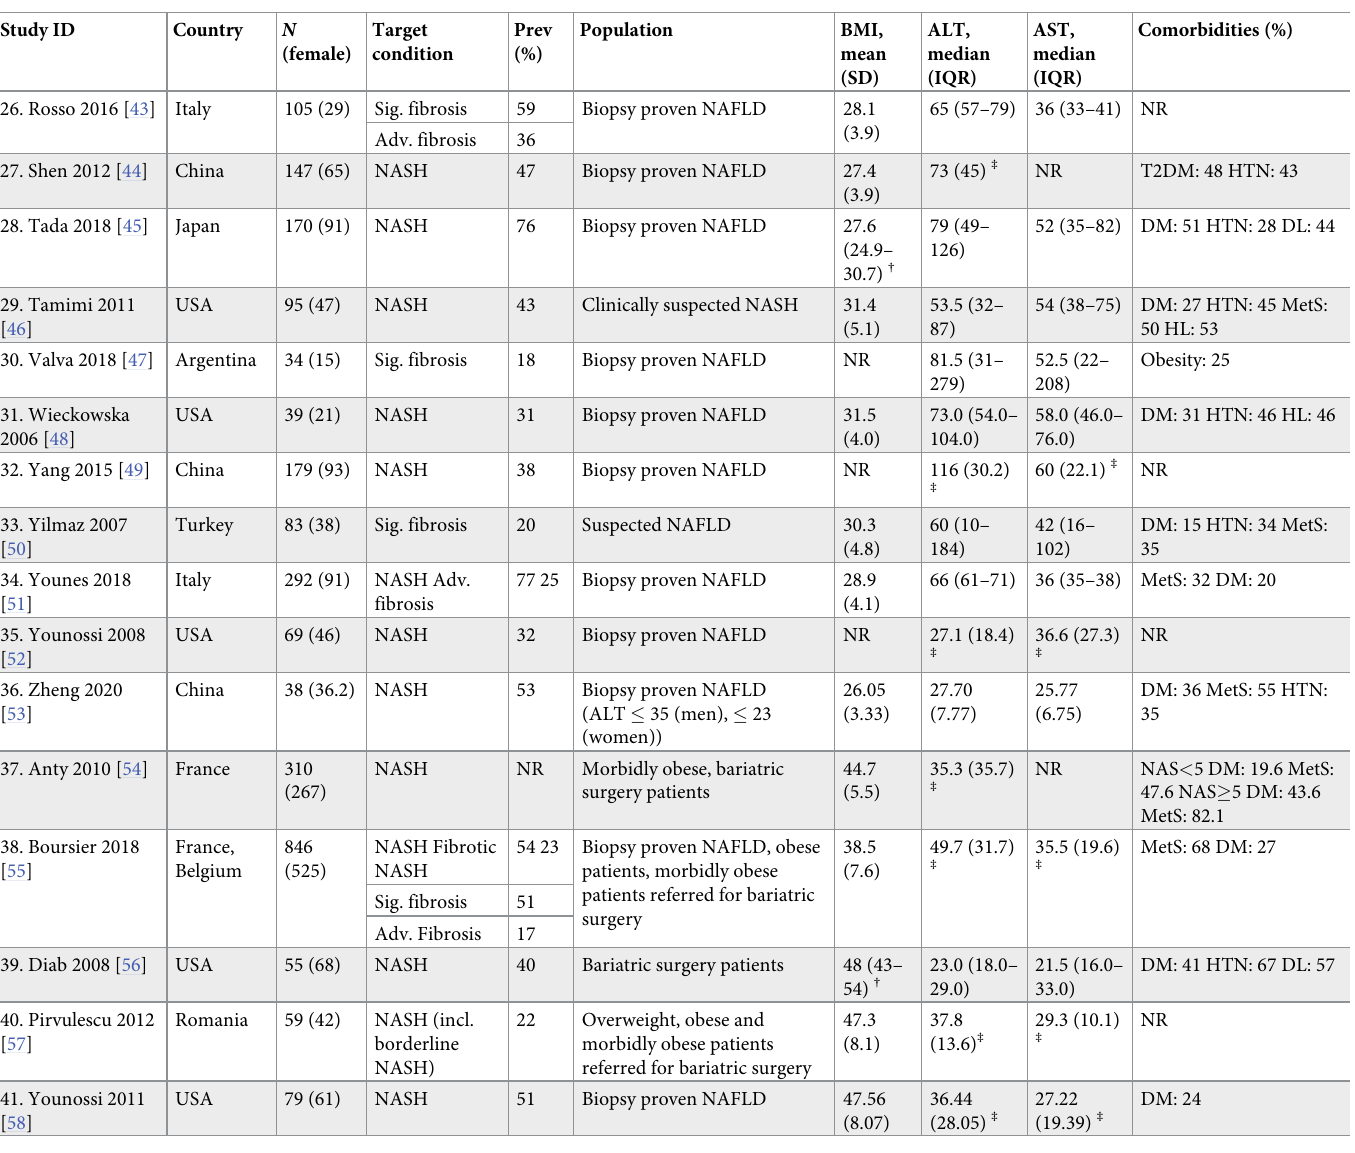
operating characteristic curve (AUC) of 0.75 (95% CI: 0.69–0.82) with a mean sensitivity of 0.61 (95% CI: 0.51–0.71) and mean specificity of 0.81 (95% CI: 0.71–0.88). The Youden-thresh- old value was 304 U/L (Fig 2A). Using the multiple thresholds model, we calculated the positive predictive value (PPV) and the negative predictive value (NPV) under different clinical settings (5% to 70% NASH preva- lence) for desired levels of sensitivity and specificity (Table 2). Optimizing sensitivity (0.80